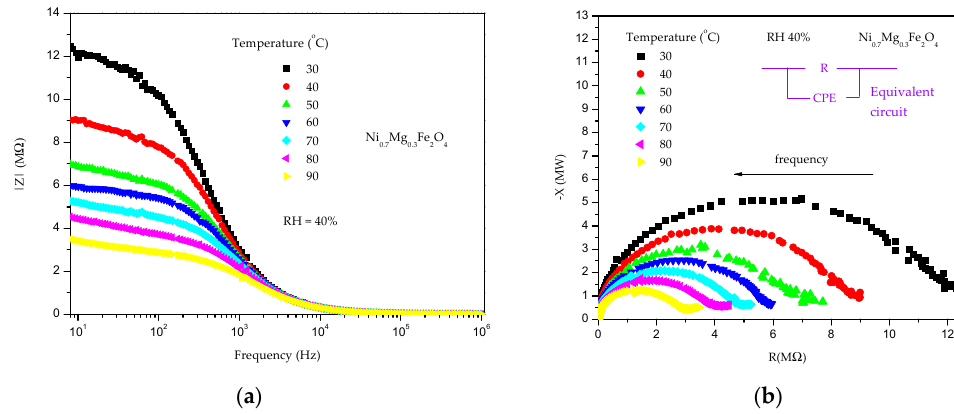
Figure 9. Change of impedance component ( a ) and complex impedance ( b ) with the change in temperature at a constant RH of 40% for Ni 0.7 Mg 0.3 Fe 2 O 4.